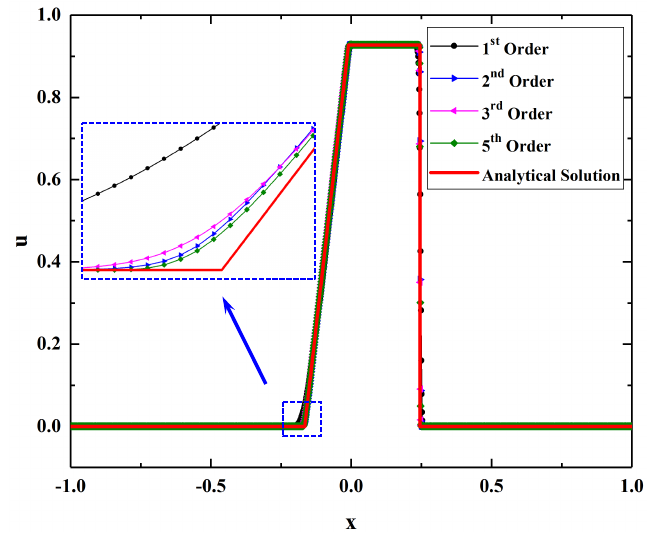
Figure 2. The velocity profiles of the Sod shock tube problem at time t =